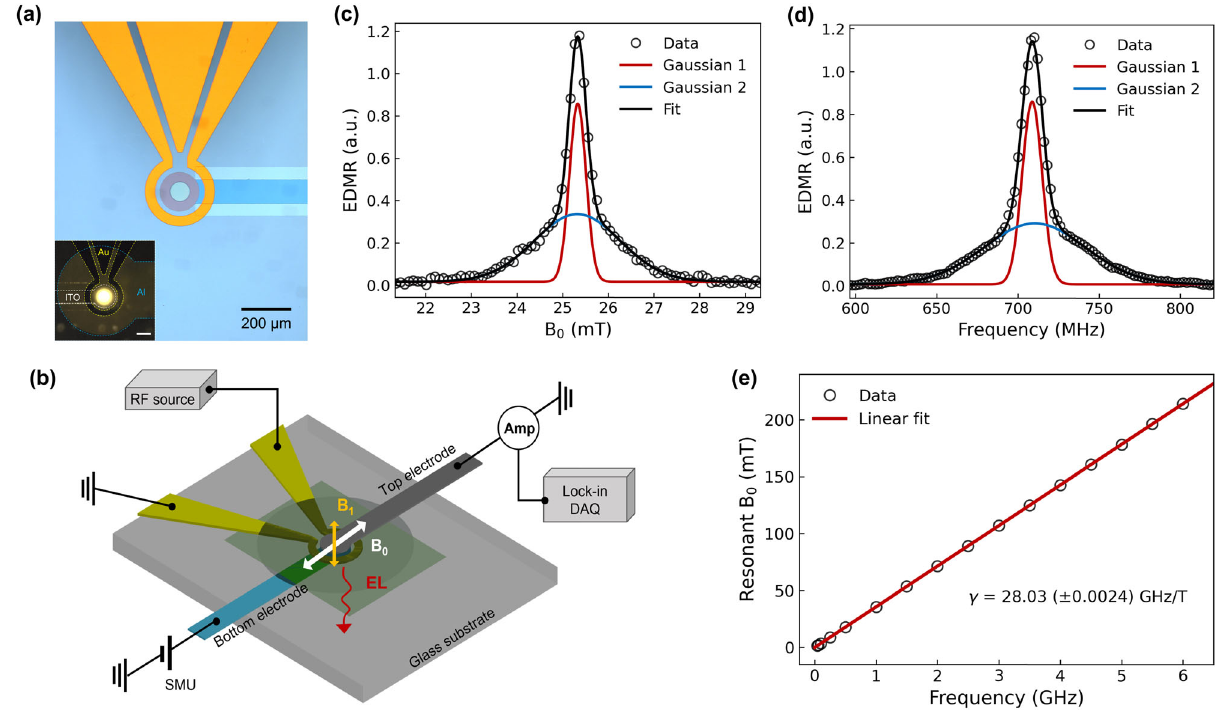
fi eld distributions ( σ σ 1 =0.18(2), 2 =0.94(2)) experienced by the electron and hole spins, respectively. σ 1 and σ 2 represent the standard deviation of the two Gaussian functions. d Afrequency-sweptEDMRspectrumwherethemicrowavefrequencyis swept with a fi xed magnetic fi eld B 0 ≈ 25.2(5) mT via fi xing the current in the electromagnet. The spectrum can be well fi tted using two Gaussian functions with standard deviation of σ 1 =6.15(1) and σ 2 =31.23(0), respectively. We note that the background noise caused by the frequency sweep is removed from the plots in d . More details are discussed in Supplementary Method 2. e Plot of the maximum- peak value of the magnetic fi eld B 0 in the EDMR spectrums as a function of the applied microwave frequency. A linear fi t (red line) of the data yields a gyromag- netic ratio γ =28.03 (±0.0024)GHz/T and a corresponding g -factor g =2.0026